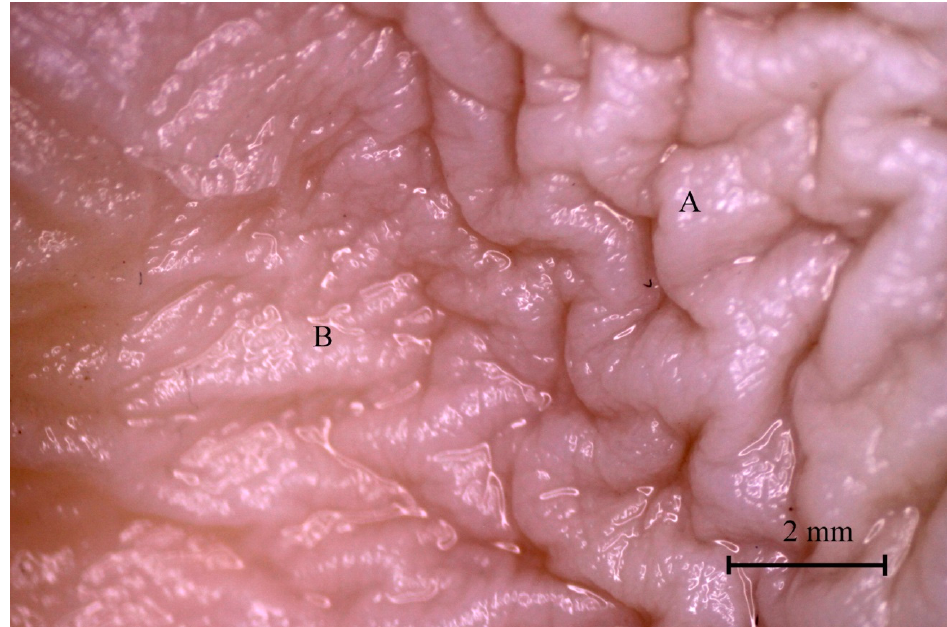
Figure 14. Gastric mucosa in the plicated edge margin region (the third age group). A—non-glandular part, B—glandular part.